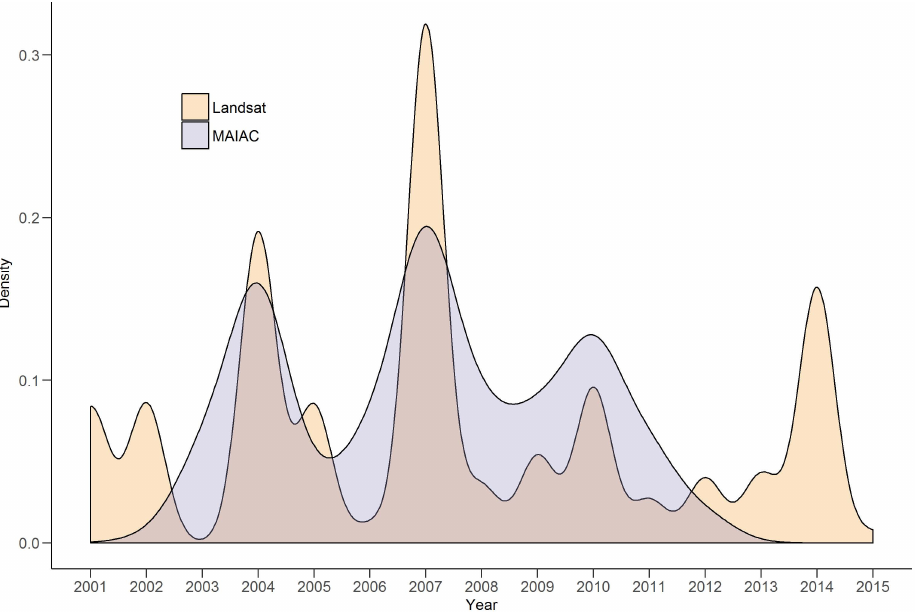
Figure 8. Comparison between breakpoint years detected using MAIAC and Landsat-based disturbance analyses across study